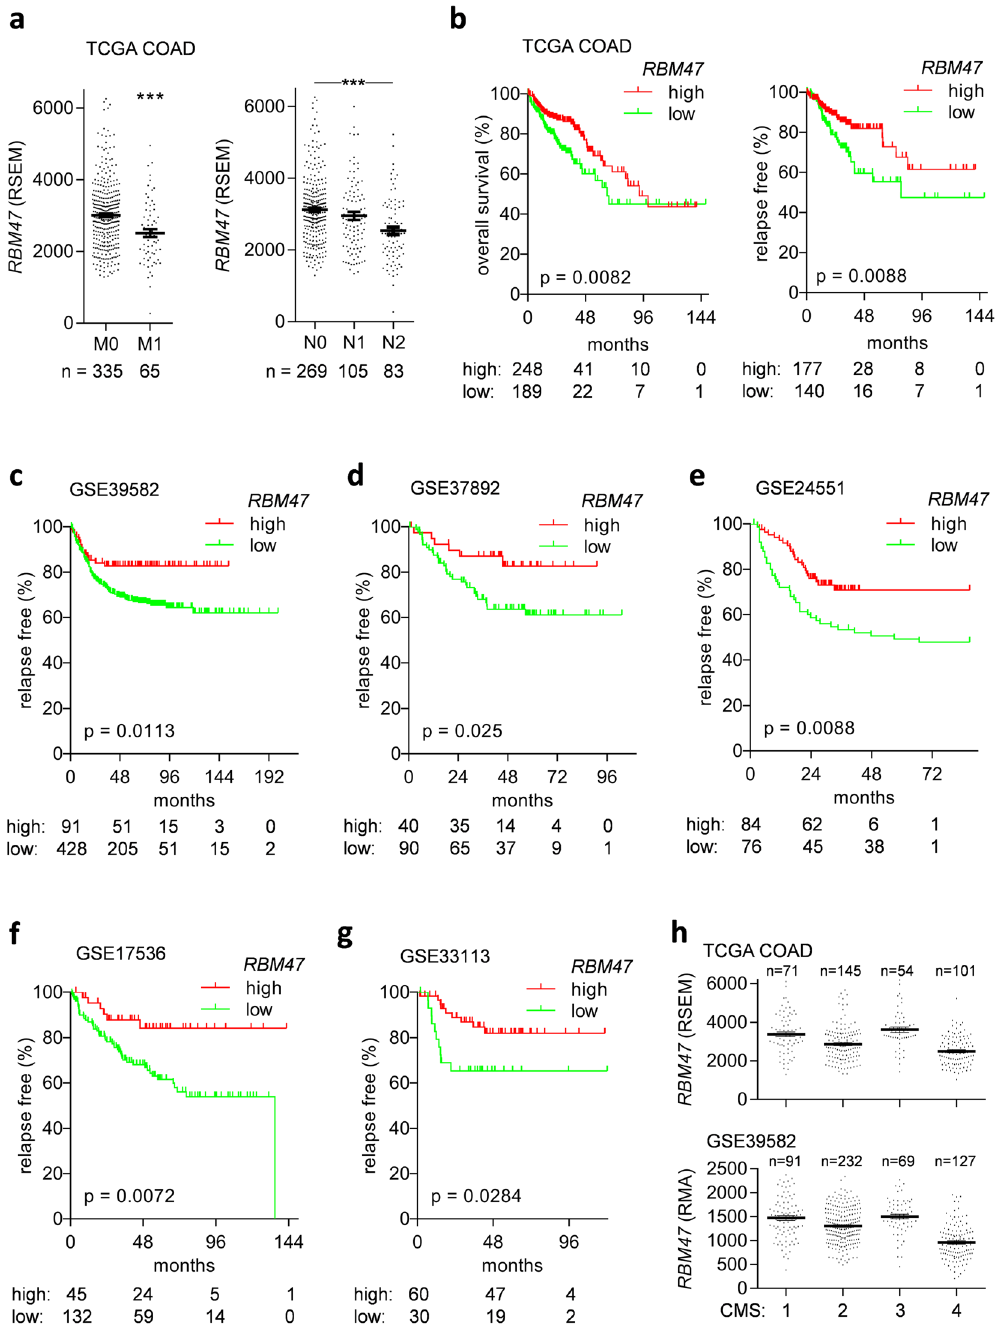
Figure 3. Low expression of RBM47 mRNA is associated with metastasis, nodal status, and poor survival in CRC patients. ( a ) Association of RBM47 mRNA expression with metastasis (right) and nodal status (left) in the TCGA COAD dataset. ( b ) Association of RBM47 mRNA expression with overall and relapse free survival in the TCGA COAD dataset. ( c – g ) Associations of RBM47 mRNA expression with relapse free survival in indicated CRC dataset. ( h ) Association of RBM47 mRNA expression with the consensus molecular subtypes (CMS) of colorectal cancer in TCGA and GSE39582